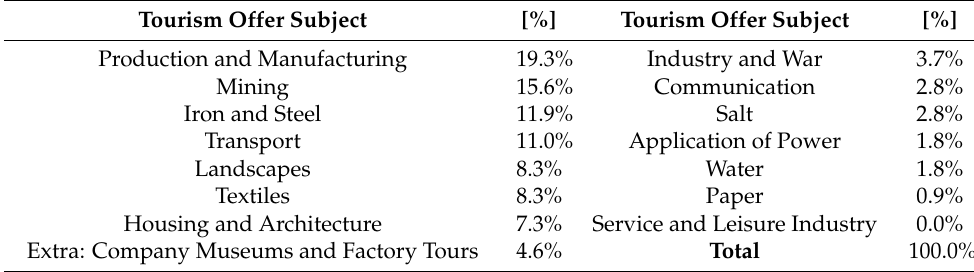
Table 2. Themed issues presented by the examined tourist sites.